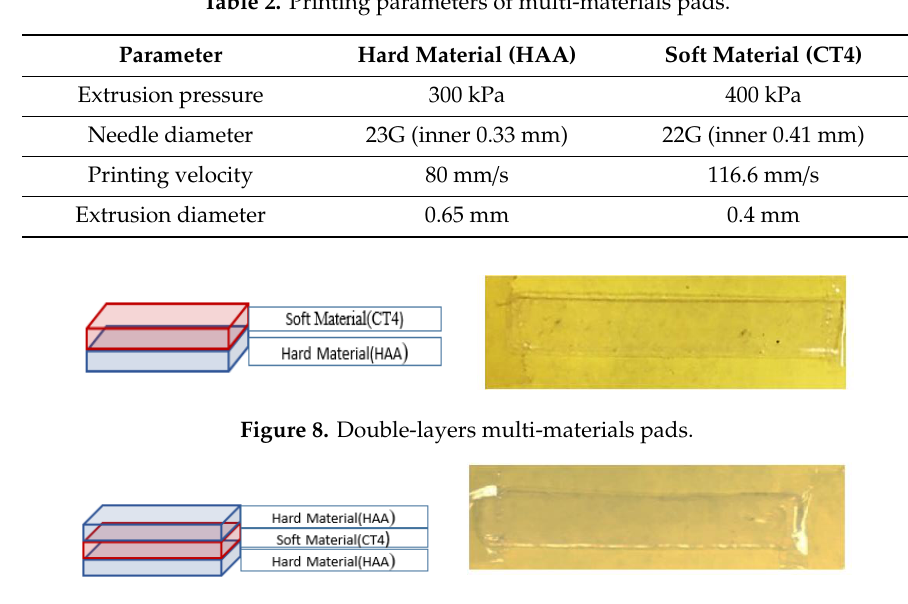
Figure 9. Triple-layers multi-materials pads.